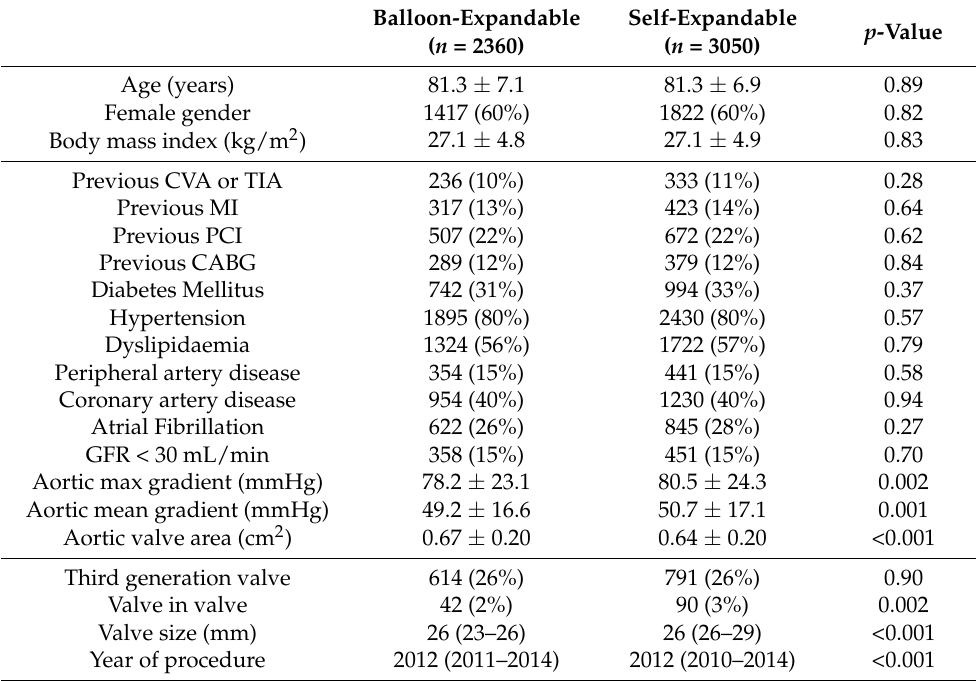
Table 1. Baseline characteristics of the matched patient population included in this